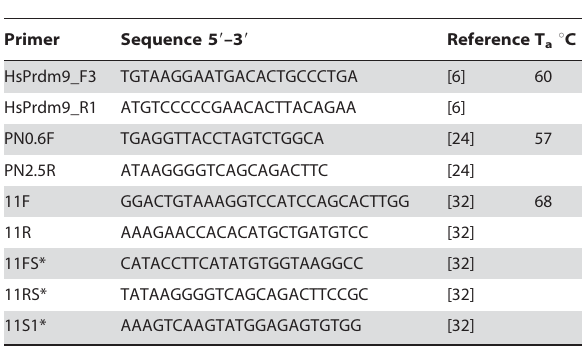
Table 2. Primers used in this